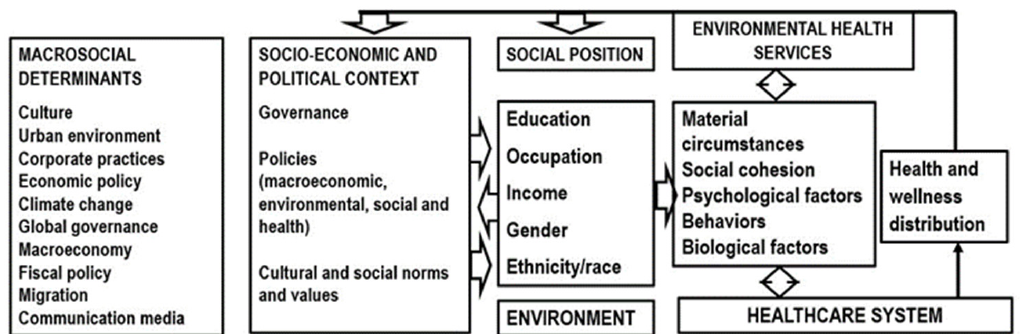
Figure 3. Conceptual framework of the social determinants of health. Source: Mújica and Moreno [43].